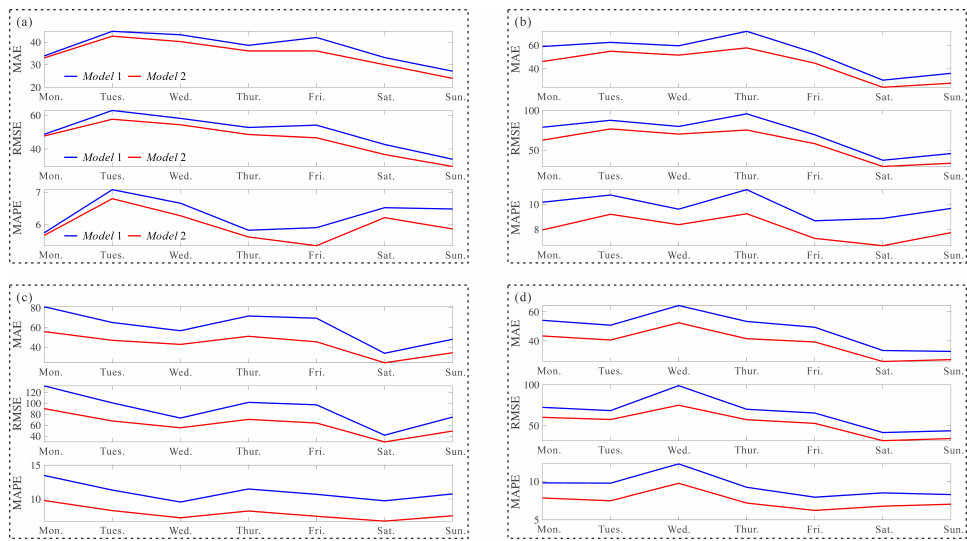
Figure 14. Average MAE, RMSE, and MAPE values of Models 1 and 2 from Monday to Sunday in ( a ) Area I; ( b ) Area II; ( c ) Area III; ( d ) Area